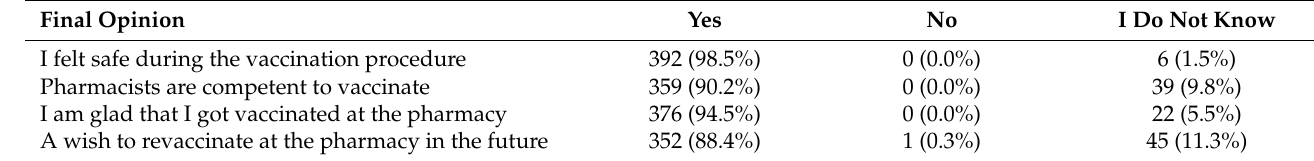
Table 4. Opinions regarding satisfaction with immunization at the